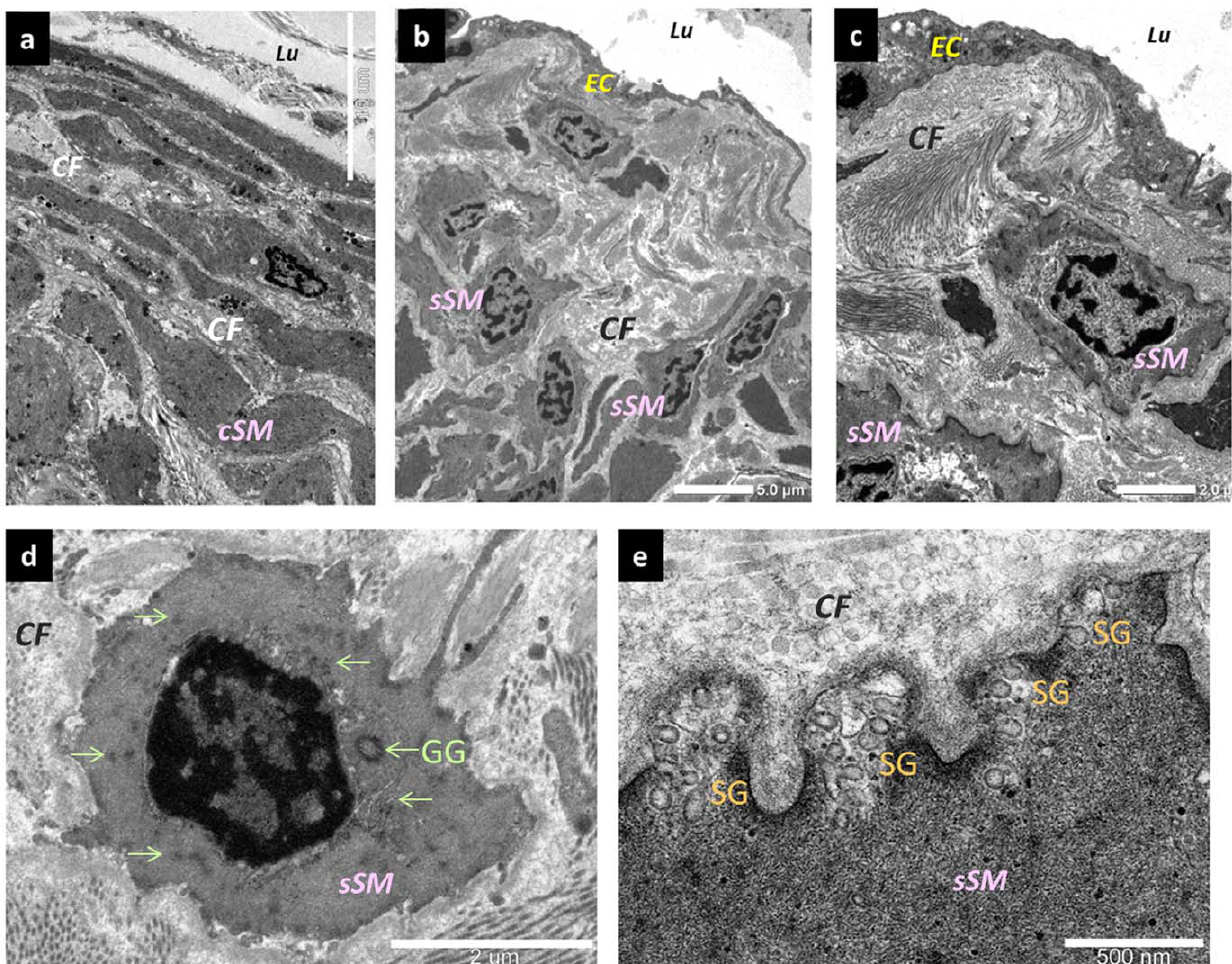
Figure 6. Changes in smooth muscle cells. (a) Normal type. They are present in the medial layer of the collecting lymphatic vessels, as contractile smooth muscle cells. Synthetic smooth muscle cells are only partially present. Bar=10 m m. (b) Changes affecting the smooth muscle cells in the contraction type. Synthetic smooth muscle cells migrated directly beneath the endothelial cells and proliferated. Bar=5 m m. (c) Synthetic smooth muscle cells stimulated collagen fiber hyperplasia directly beneath the lymphatic vessel endothelial cells. Bar=2 m m. (d) Synthetic smooth muscle cells. An increase in glycogen granules inside the cells is evident. (e) The periphery of synthetic smooth muscle cells. Secretory granules are present in large numbers. Bar=500 nm. EC; endothelium cells, sSM; synthetic smooth muscle cells, cSM; contractile smooth muscle cells, CF; collagen fibers, GG; glycogen granules (green arrows), SG; secretory granules.